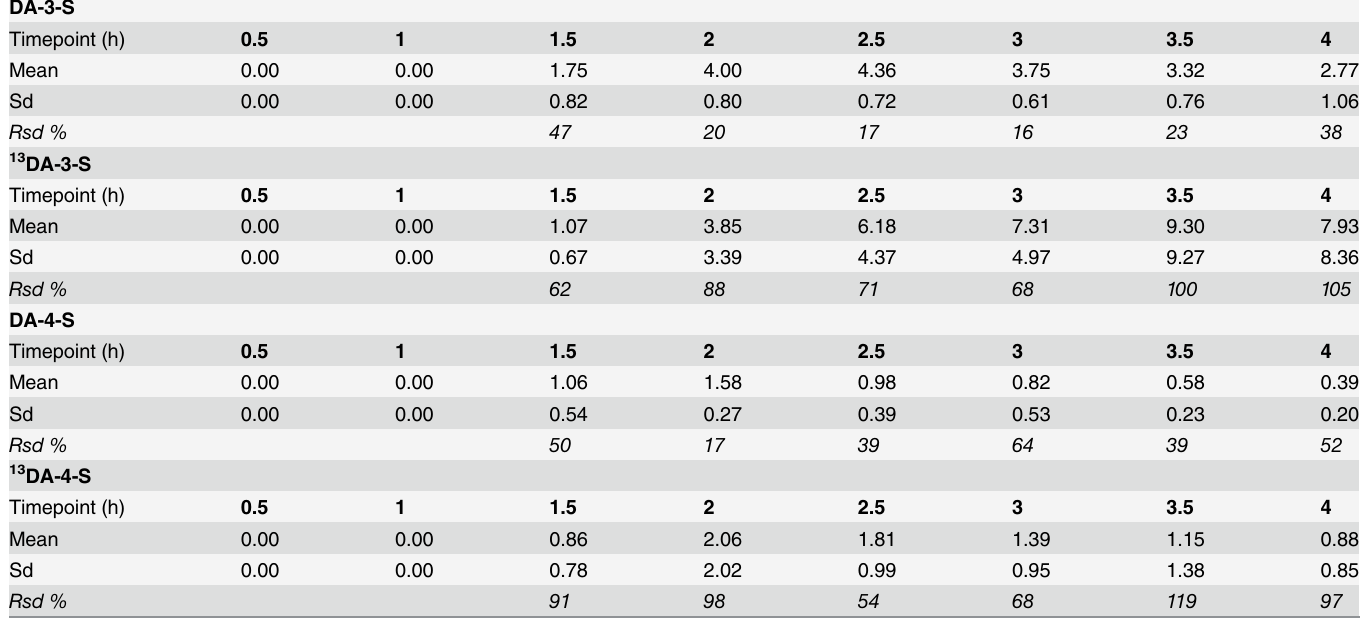
Table 2. Mean concentrations (nM) and standard deviations between the rats (see Fig 2) for DA-3-S, 13 DA-3-S, DA-4-S and 13 DA-4-S at the time- points of microdialysis sampling.